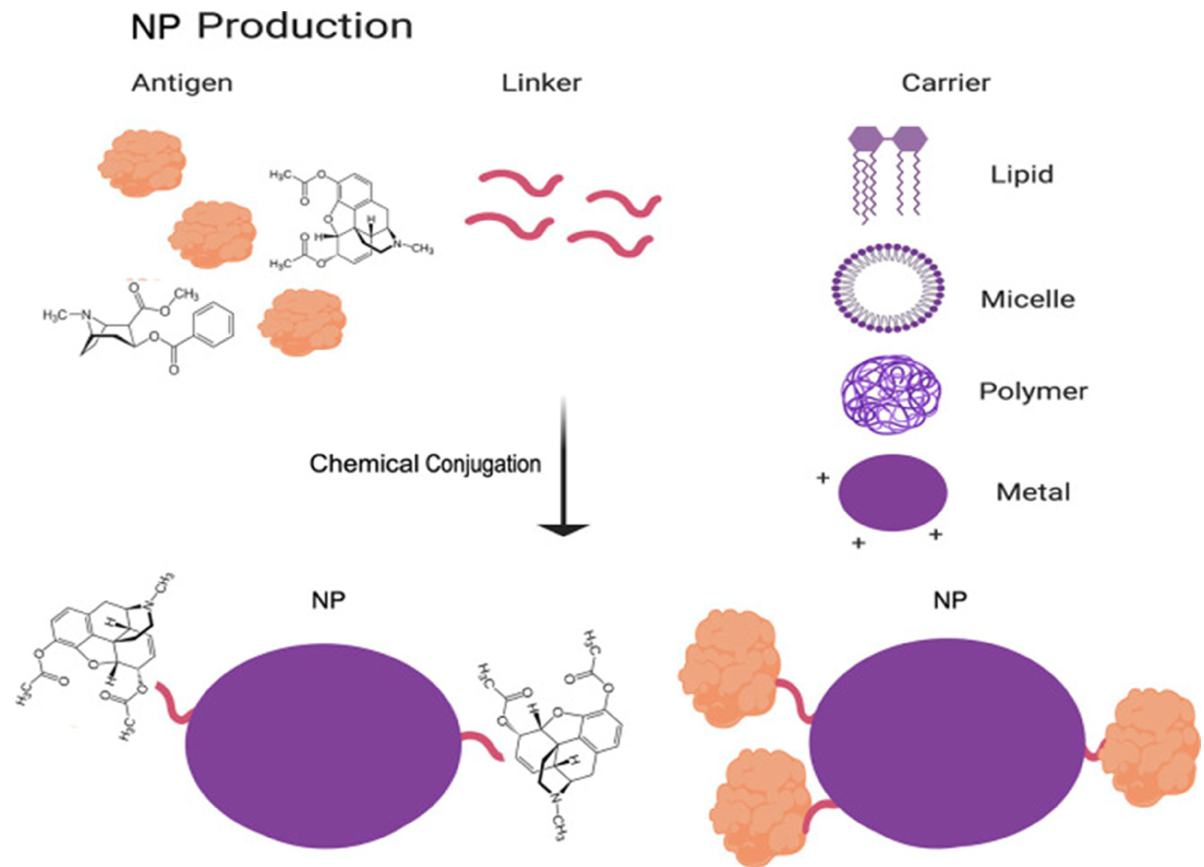
Figure 6. Schematic representation of nanoparticle vaccine production. Reprinted from [153]. CC-BY 4.0 (https://creativecommons.org/licenses/by/4.0/). Accessed 8 February 2021.